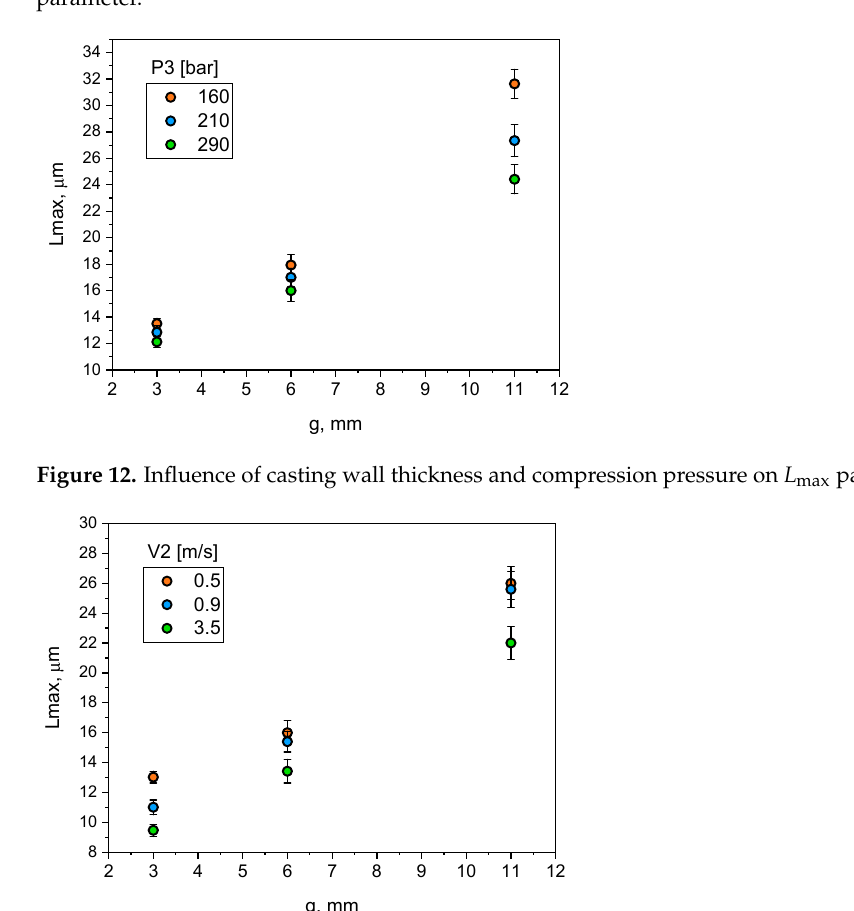
Figure 11. Influence of casting wall thickness and plunger velocity in the pressing chamber on d α parameter.